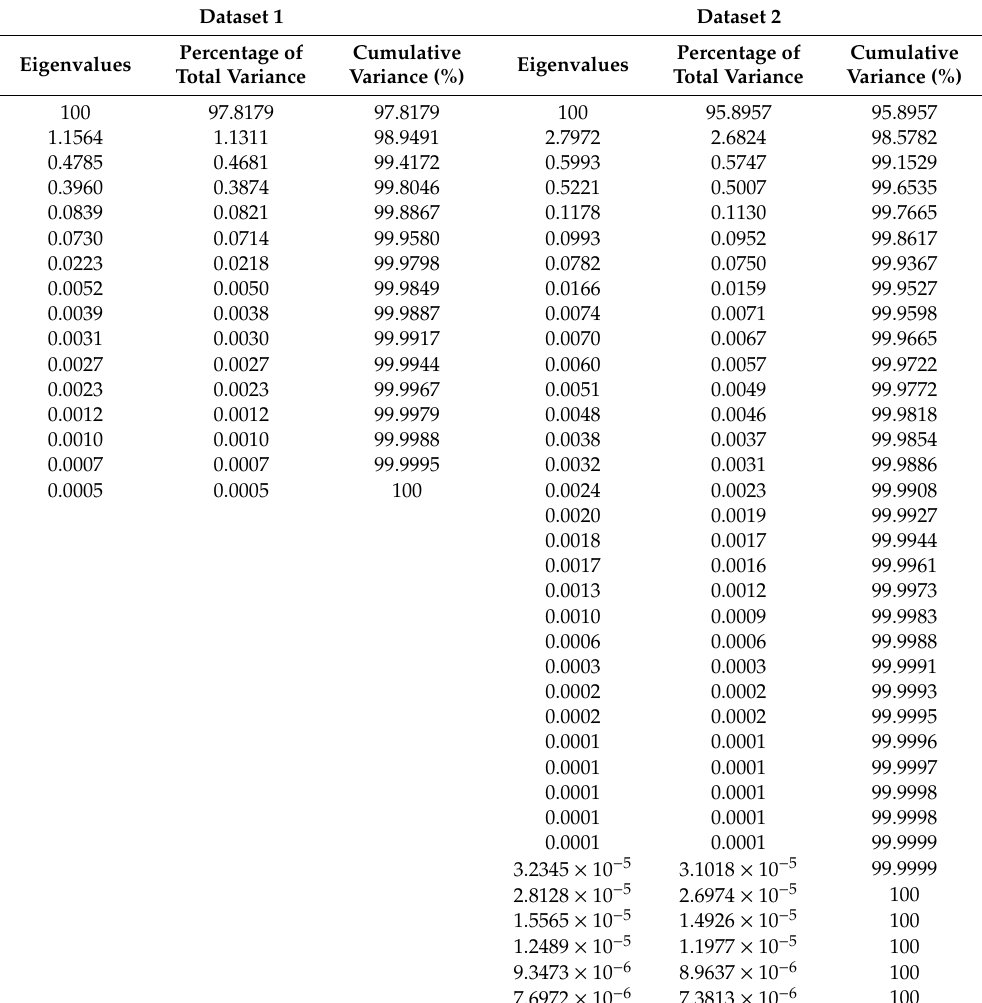
Table 5. Eigenvalues for both datasets of the henry hub natural